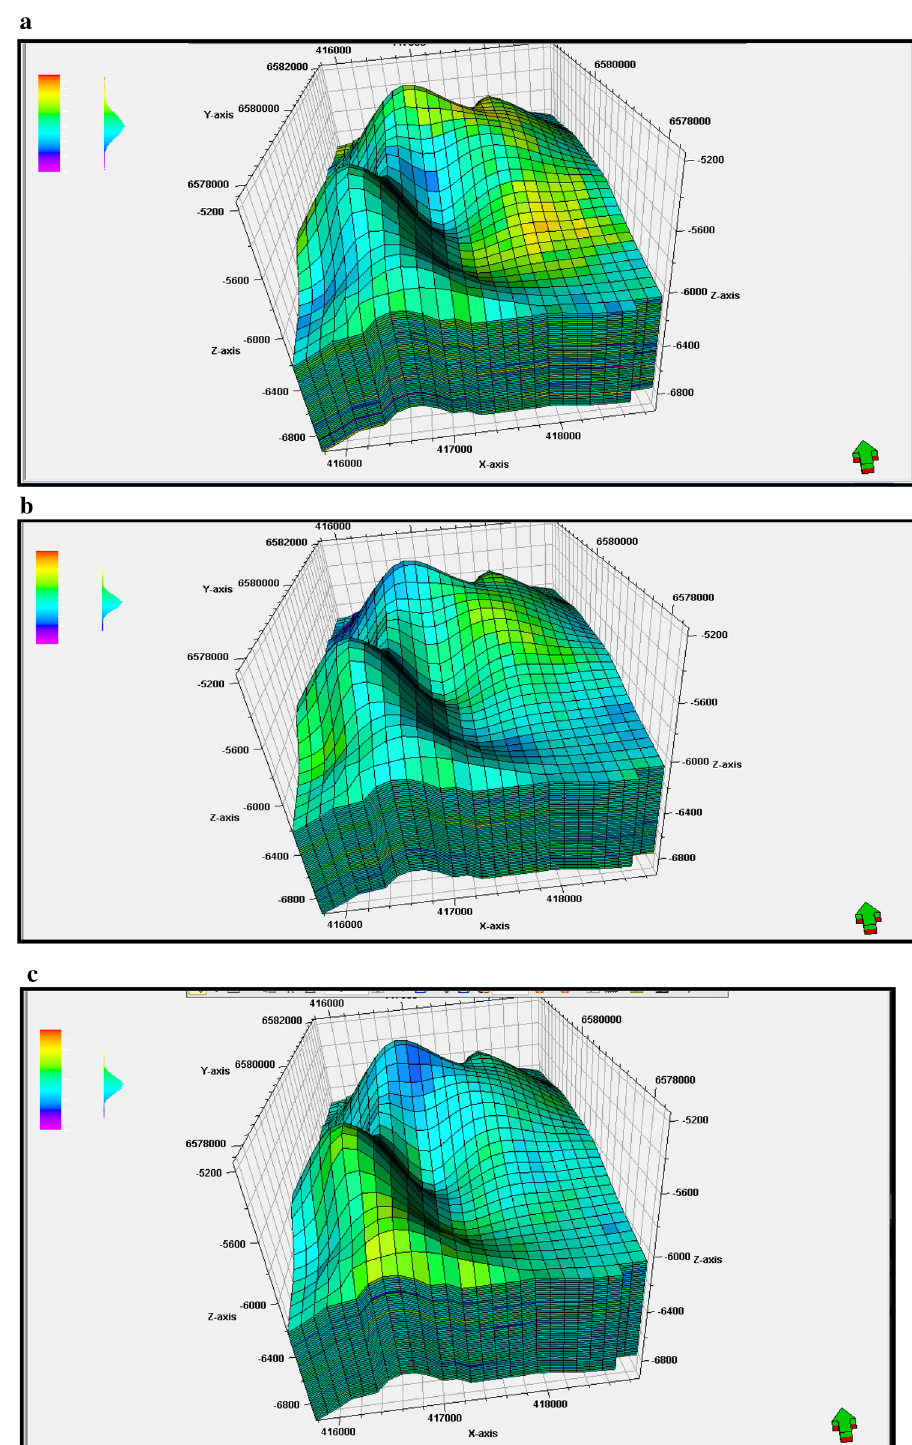
Fig. 4 a Porosity_2185421 model of the reservoir. b Porosity_2148526 model of the reservoir. c Porosity_1987521 model of the reservoir. d Porosity_963584 model of the reservoir. e Porosity_745256 model of the